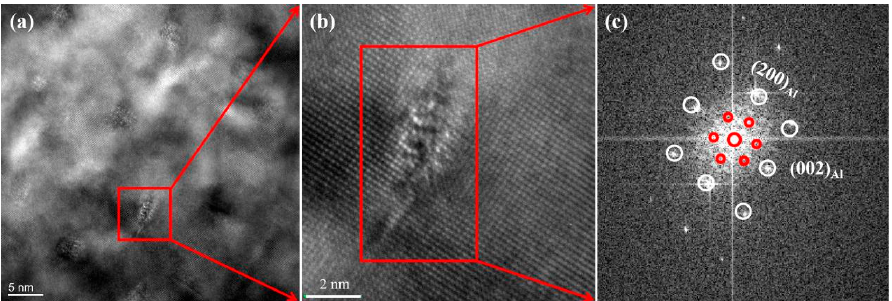
Figure 9. Q ′ phase in A3 alloy in the <010>Al axis after aging treatment: ( a ) TEM image, ( b ) HRTEM image, ( c ) corresponding FFT.